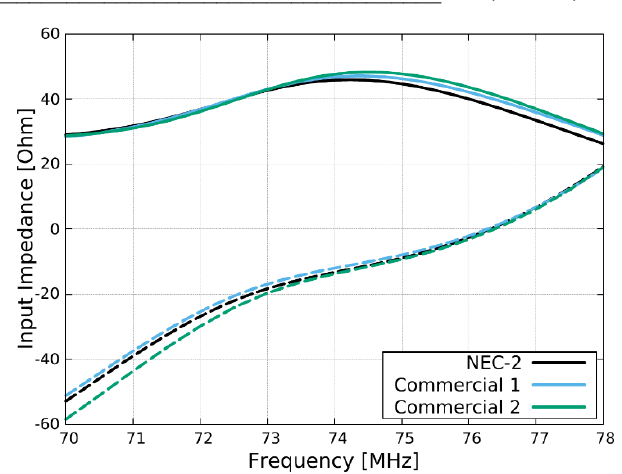
Fig. 7. Feeding point impedance of the analysed three-element Yagi. Black line: nec2c; Blue line: commercial code 1; Green line: commercial code 2. Continuous lines: real part; Dashed lines: Imaginary part.